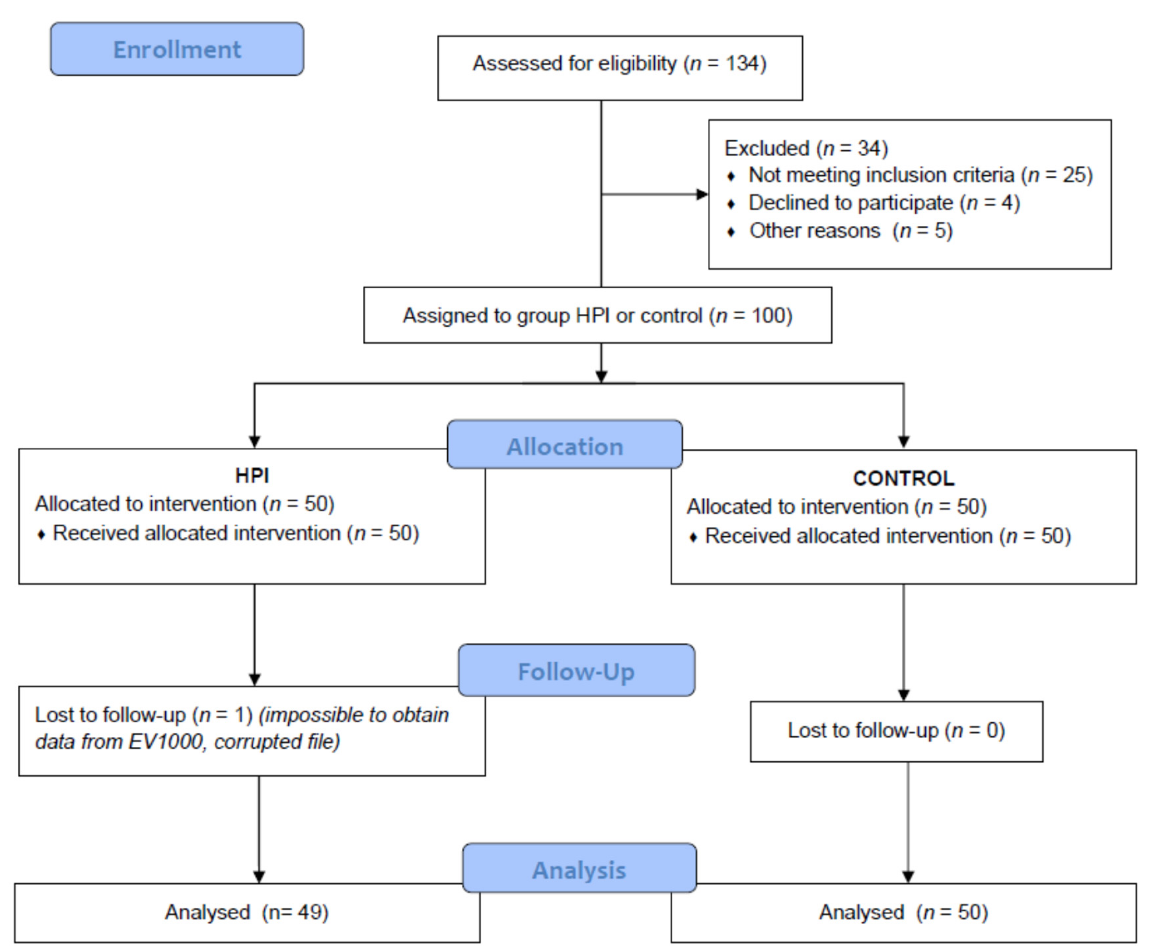
Figure 2. Participant flow diagram.